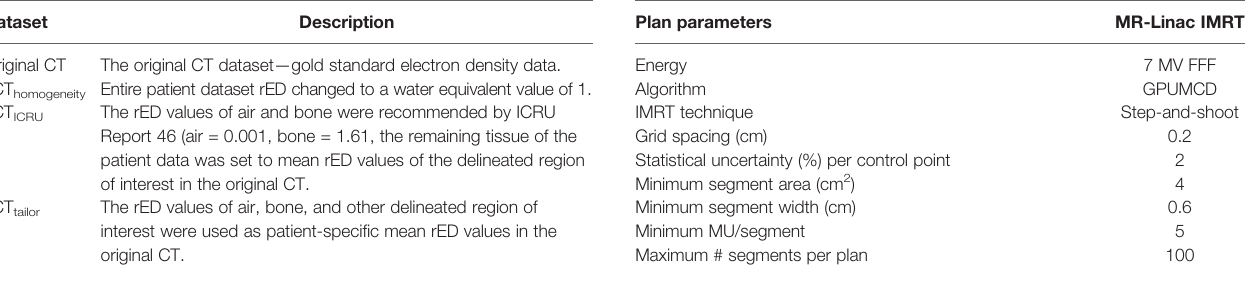
TABLE 1 | Datasets and description used in the study. TABLE 2 | Calculation and segmentations for the IMRT